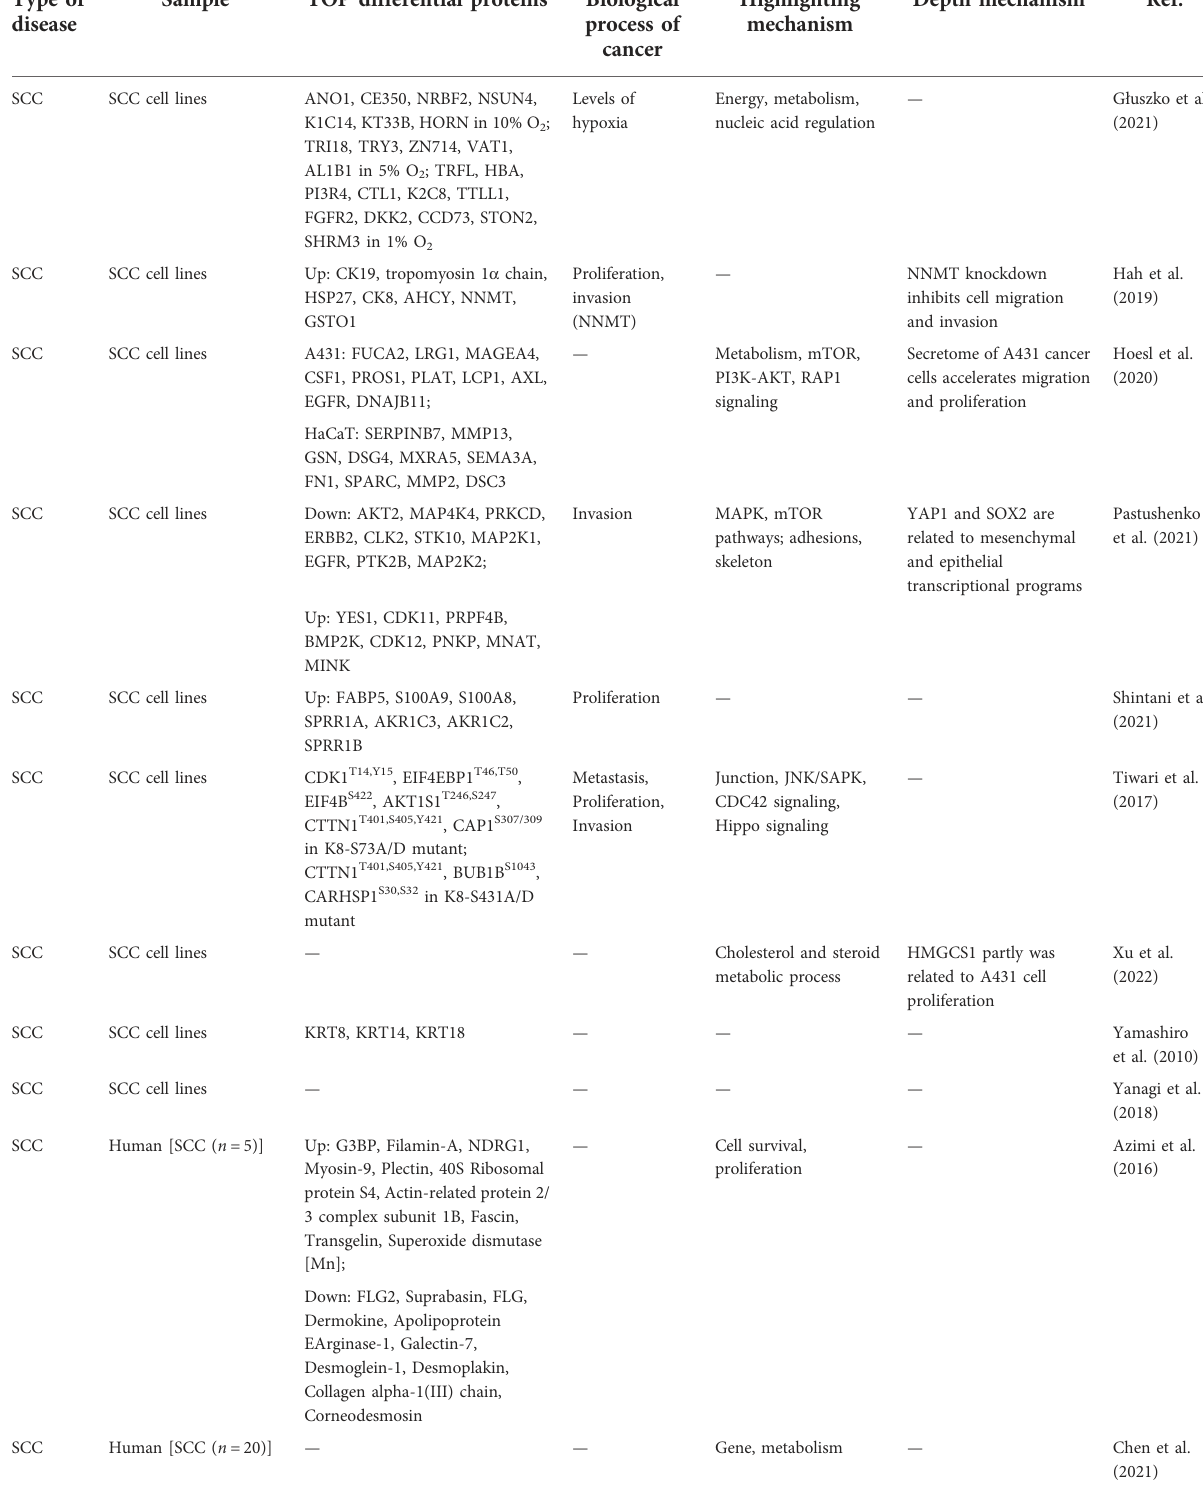
TABLE 1 Mechanism of squamous cell carcinoma pathogenesis within proteomic